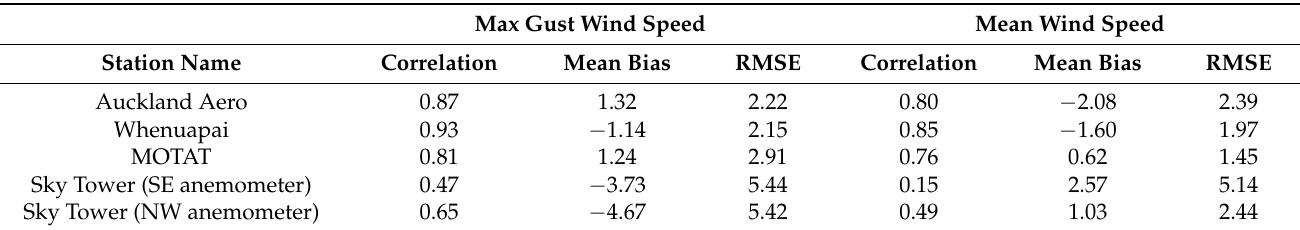
Table 2. Summary statistics for comparison between the observed and Auckland Model forecast gust and mean wind speeds at the location of the four stations.